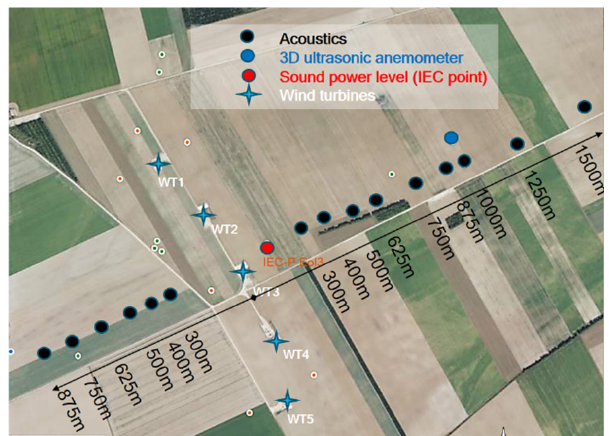
Figure 1. General overview of the experimental set-up for the validation of the numerical model. Location of sound level measurements (black points), wind measurements (blue points), wind turbine sound power level measurements (red points), wind turbines (blue crosses).